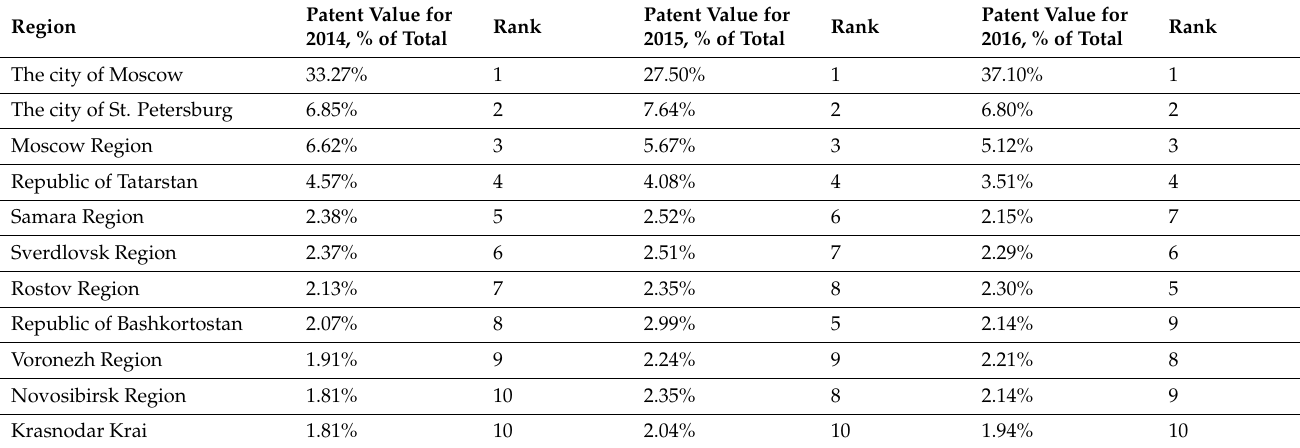
Table 8. Top 10 regions with the highest patent indicator for